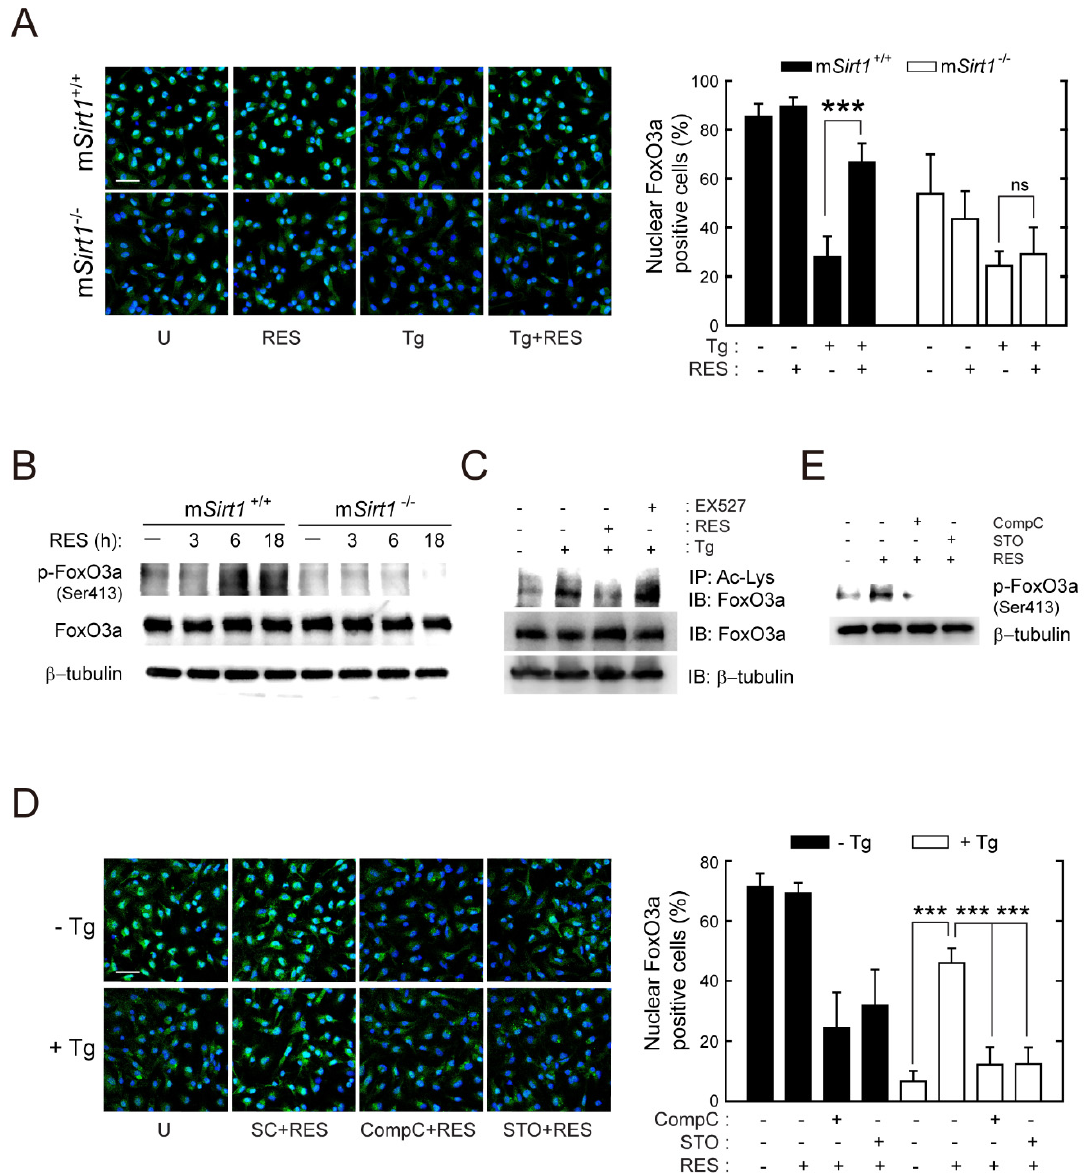
Figure 6. RES treatment promotes the activation of FoxO3a, which is mediated by SIRT1 and AMPK. ( A ) BMDMs from m Sirt1 +/+ and m Sirt1 − / − mice were infected with the RH strain (MOI = 1, for 2 h) and then further stimulated with RES (10 µ M) for 18 h. Cells were fixed and immunostained with an anti-FoxO3 antibody (Alexa Fluor 488-conjugated goat anti-rabbit IgG, green) and DAPI for nuclei (blue). Cells were then subjected to immunofluorescence microscopy. Representative images (left) and quantitative data (right) showing the cytoplasmic translocation of FoxO3a were obtained from one representative of 3 independent samples, with each experiment containing a minimum of 50 cells scored in 7 random fields. Scale bar = 25 µ m. ( B ) BMDMs from m Sirt1 +/+ and m Sirt1 − / − mice were stimulated with RES (10 µ M) for the indicated time periods. The phosphorylation of FoxO3 (Ser413) was determined by immunoblot analysis. ( C ) BMDMs were infected with T. gondii for 18 h in the presence of RES (10 µ M) or EX527 (4 µ M). Cell lysates were subjected to immunoprecipitation analysis using an anti-acetylated-lysine antibody (Ac-Lys), and then the immunoprecipitates were analysed by Western blot using an anti-FoxO3a antibody. Cell lysates were harvested and subjected to Western blot analysis for FoxO3a and β -tubulin, as loading controls. ( D ) BMDMs were pretreated with Compound C (25 µ M) or STO-609 (10 µ M) for 45 min, then infected with RH strain (MOI =